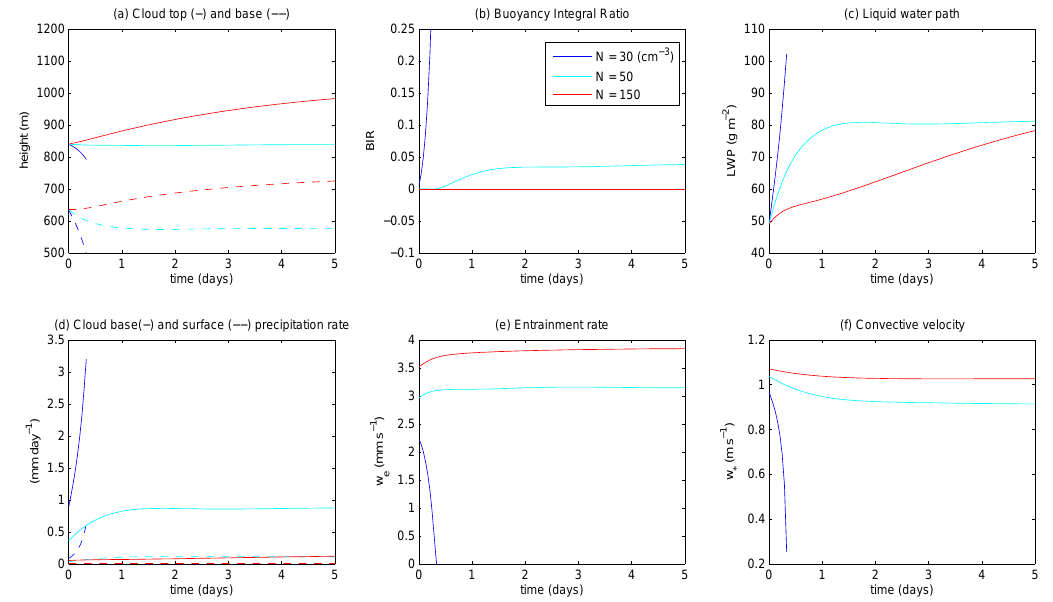
Fig. 3. MLM time series with N =30, 50 and 150 cm − 3 , using standard entrainment closure: (a) cloud top (solid) and base(dashed), (b) BIR, (c) LWP, (d) cloud base (solid) and surface (dashed) precipitation rate, (e) w e , and (f) convective velocity. Simulations are terminated if the entrainment rate drops to zero; this happens immediately for the N =10 cm − 3 case so it is not shown.